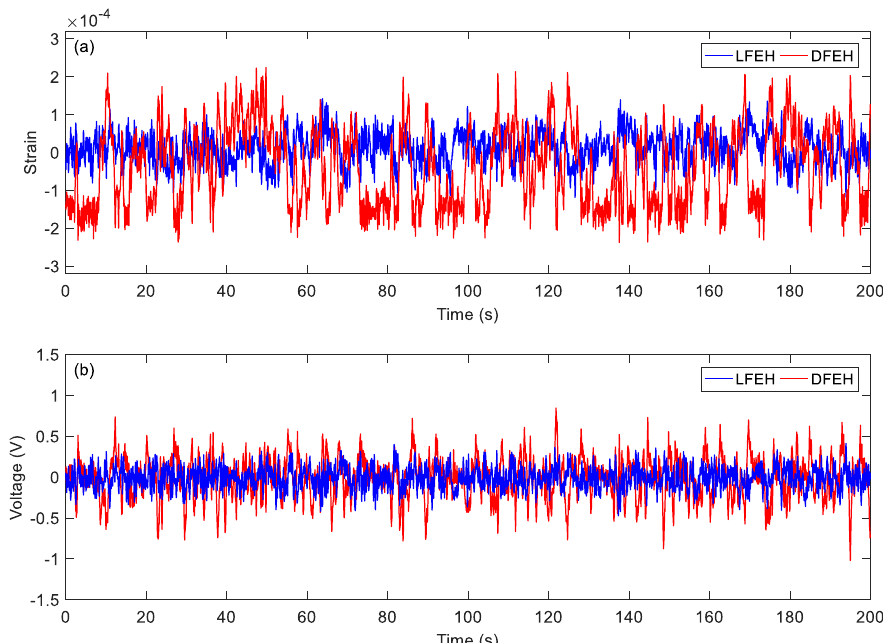
Figure 17. ( a ) Time histories of strain response, ( b ) time histories of voltage response ( v = 6.0 m/s).